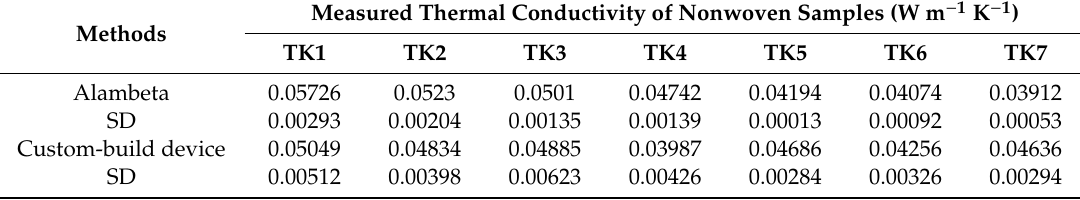
Table 8. Measured thermal conductivities of the nonwoven samples.